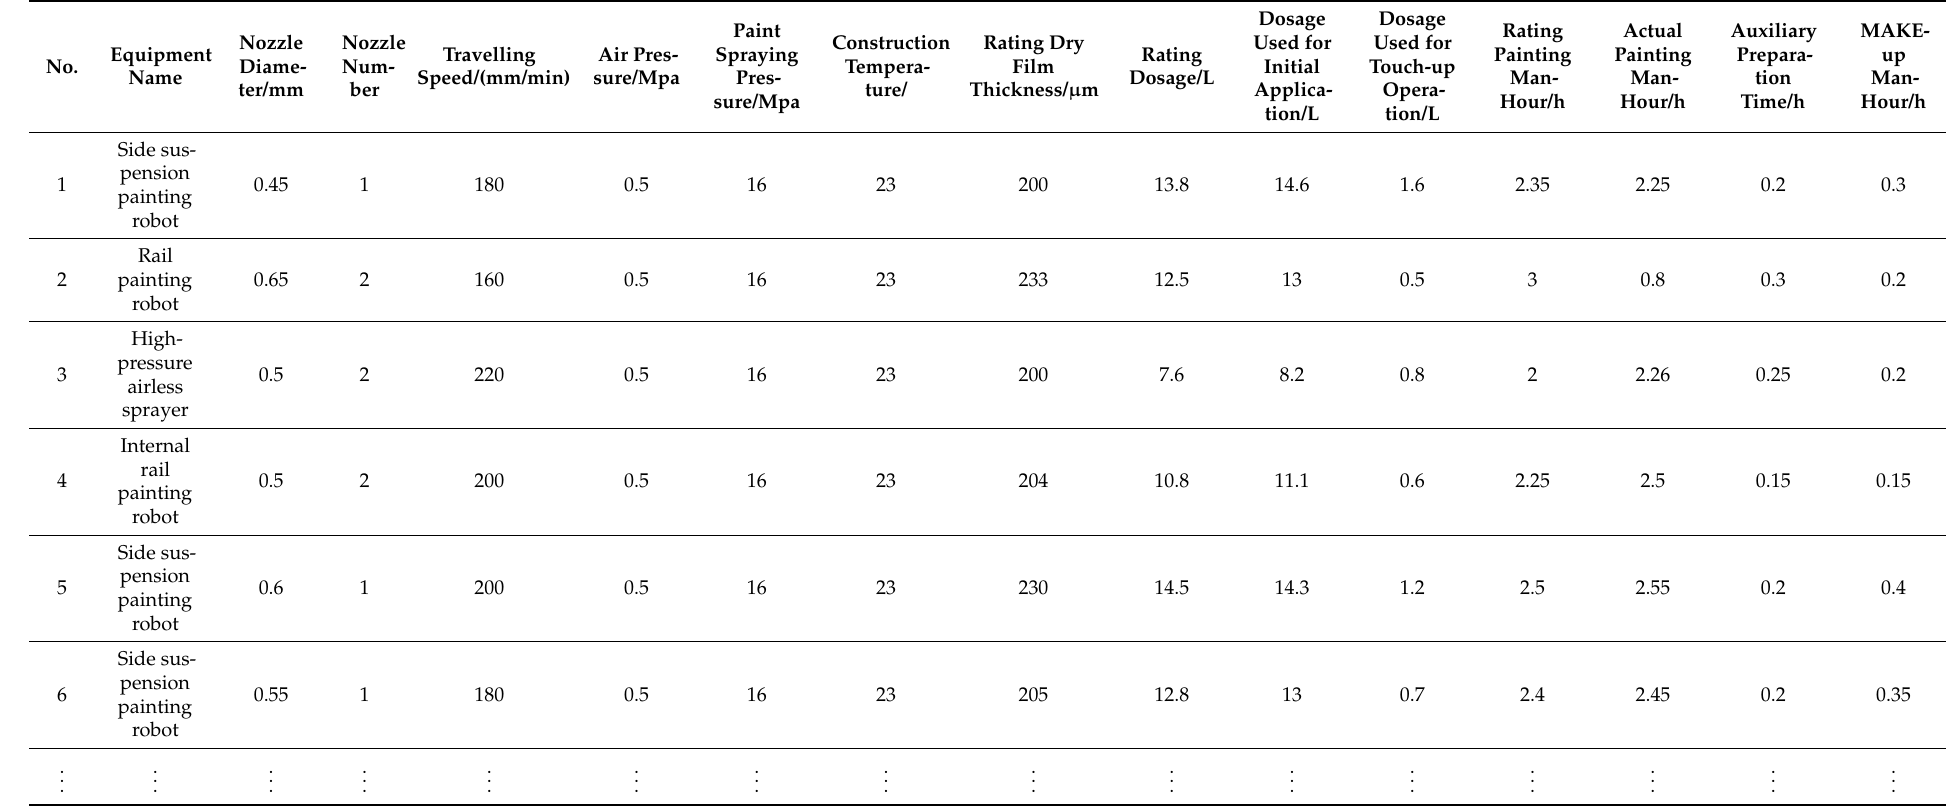
Table 7. Painting process cases